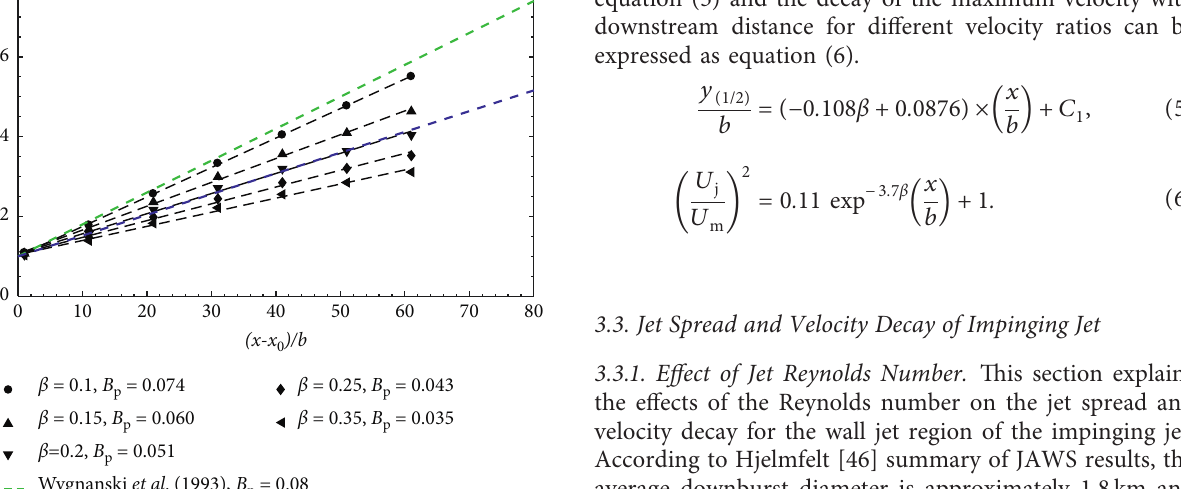
Figure 14: Decay of maximum velocity for various velocity ratios.